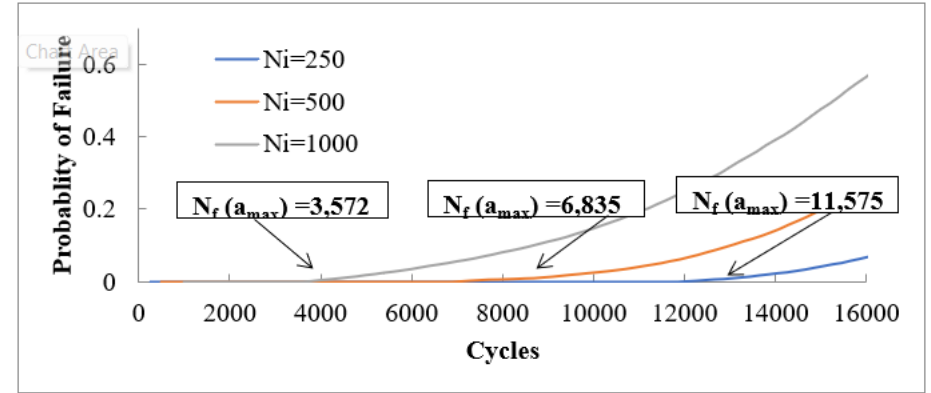
Figure 13. Probability of failure increases as the crack initiation life increases.